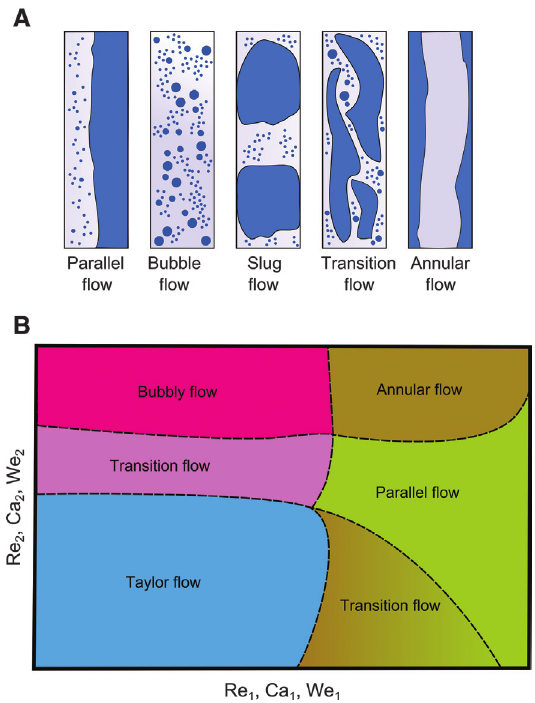
Figure 2 Multiphase flow pattern (A) and flow-regime diagram (B) in multiphase microstructured